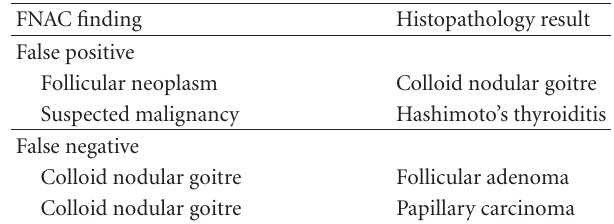
Table 4: Summary of false positive and false negative results of FNAC.